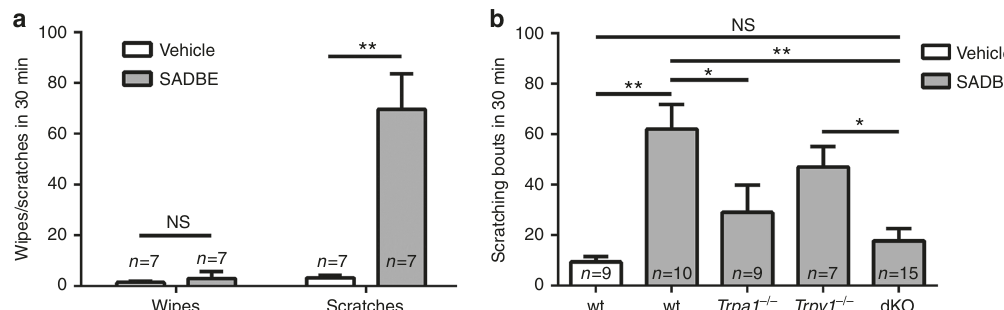
Fig. 5 TRPA1 is the primary mediator of SADBE-induced acute itch. a Bar charts illustrate acute itch and pain behaviors in wt mice by cheek injections of SADBE (30 mM). Facial wiping with the forelimb was indicative of a pain response, whereas scratching with the hind paw was considered as an itch response. Asterisks indicate statistical signi fi cance. Data are presented as mean ± SEM. NS, not signi fi cant. ** p < 0.01, Student ’ s t -test; b Bar charts illustrate acute itch responses elicited by intradermal injections of vehicle or SADBE (30 mM) in the neck of wt, Trpa1 − / − , Trpv1 − / − and Trpa1 − / − / Trpv1 − / − dKO mice. Data are presented as mean ± SEM. NS, not signi fi cant. Asterisks indicate statistical signi fi cance. * p < 0.05; ** p <